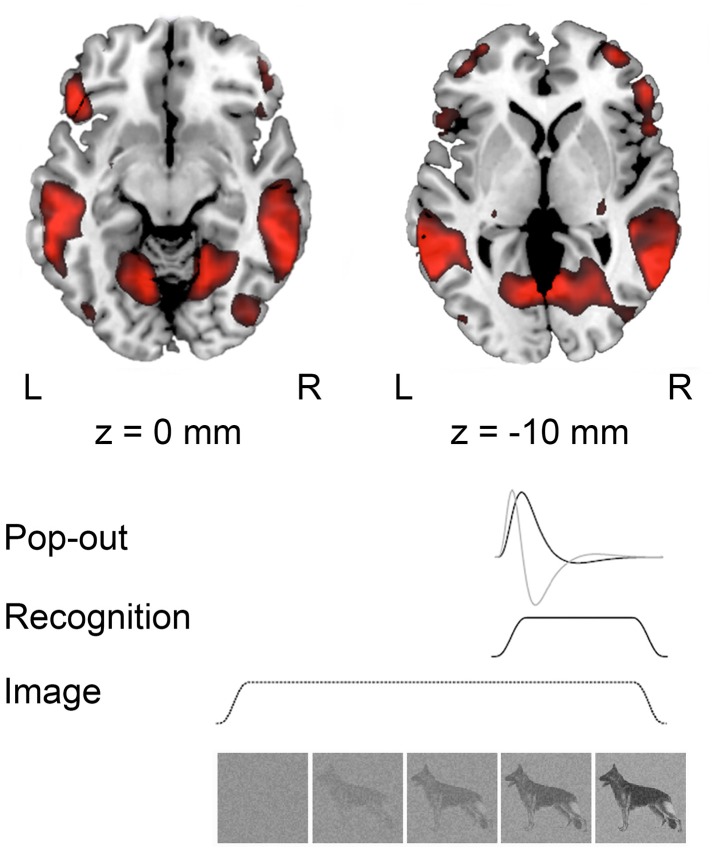
Group activations (n = 13) during recognition at p < 0.001, uncorrected projected on a standard template in MNI space. Below a schematic representation of the modeled responses during image presentation; “Pop-out” indicating the moment of recognition, “Recognition” modeled from pop-out to the end of the trial and “Image” modeling the whole trial.